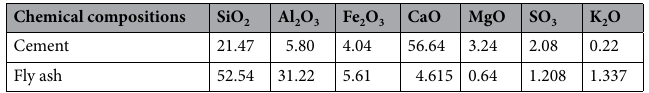
Table 2. Chemical compositions of cementitious materials (%).